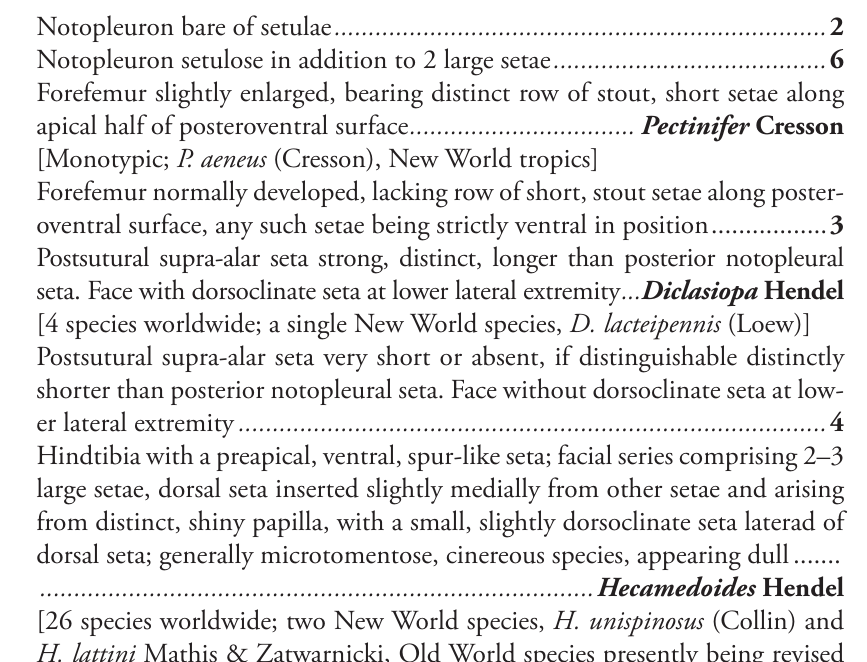
Face rather flattened, antennal grooves not always sharply defined ventrally; facial series of setae inserted very close to parafacial, dorsalmost seta not appre- ciably more removed medially than ventral seta .......... Gymnoclasiopa Hendel [26 species worldwide; 10 New World species (Mathis and Zatwarnicki 2012b)] Face rather prominent at level of dorsal facial setae, sometimes